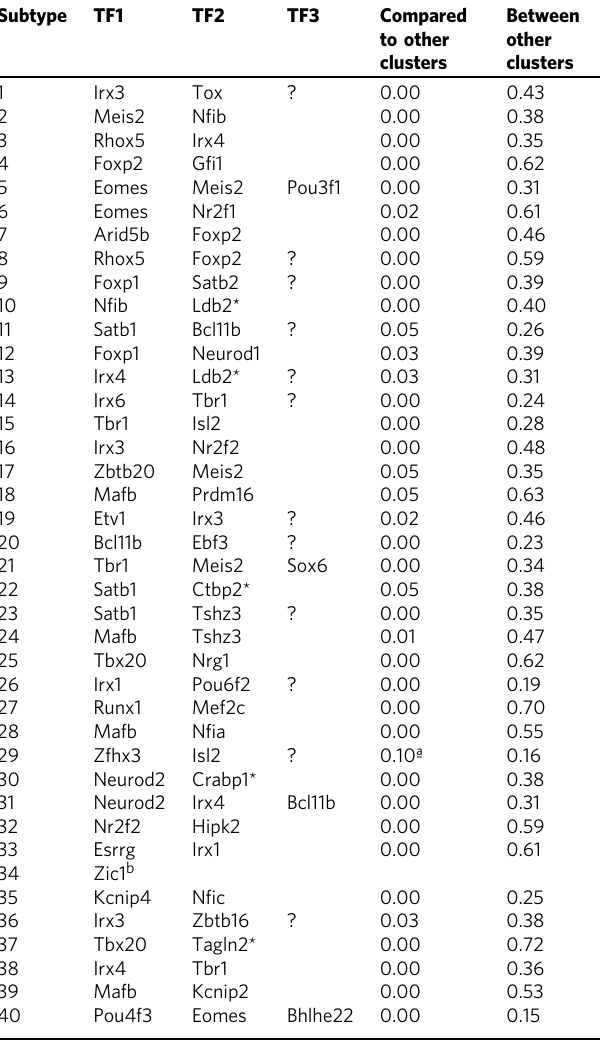
Different combinations between 46 TFs and 4 transcriptional regulators are suf fi cient to explain the differences between RGC subtypes. Where the combination explains RGC subtype differentiation from most but not all the other subtypes, a “ ? ” is shown in place of yet to be identi fi ed TF/TF regulator. Transcriptional regulators in the combinations with TFs are marked by “ * ” . Statistical interaction of the predicted TFs enrichment as a combination in respective clusters relative to every other cluster was analyzed by Repeated Measures ANOVA with Tukey ’ s HSD post hoc for pairwise comparisons (SPSS), and was signi fi cant at p ≤ 0.05 for all RGC subtypes (average p -values are shown) with sphericity assumed, except subtype 29, for which the combination does not explain differentiation from all but only from most other subtypes and therefore was signi fi cant only at p = 0.1 (marked by “ a ” ). Subtype 34 (marked by “ b ” ) is explained by a single TF (for which statistically signi fi cant p -value was calculated using a different approach, see Fig. 4), and therefore a p -value for combination is not applicable for this subtype. For comparison, TFs ’ statistical interaction in all other clusters compared to each other (excluding the cluster in which the combination was predicted to be enriched) was analyzed similarly, and it was not signi fi cant for any subtype (average p -values are